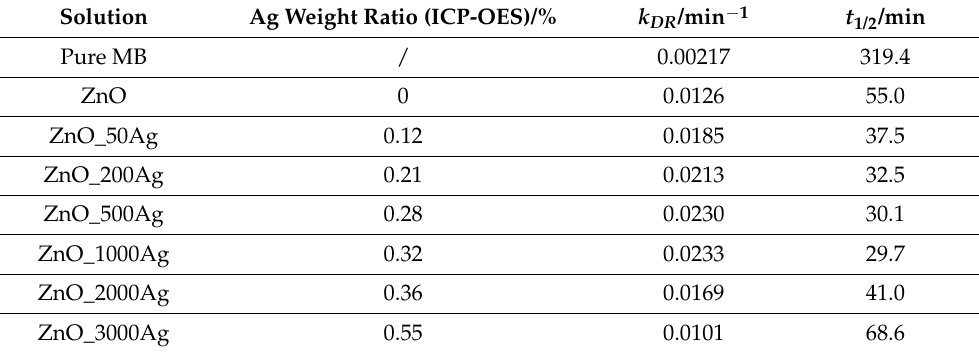
Table 2. MB photodegradation rates and photodegradation half-times under UV irradiation, derived from pseudo-first order reaction model for different Ag weight ratios in colloidal ZnO catalyst .